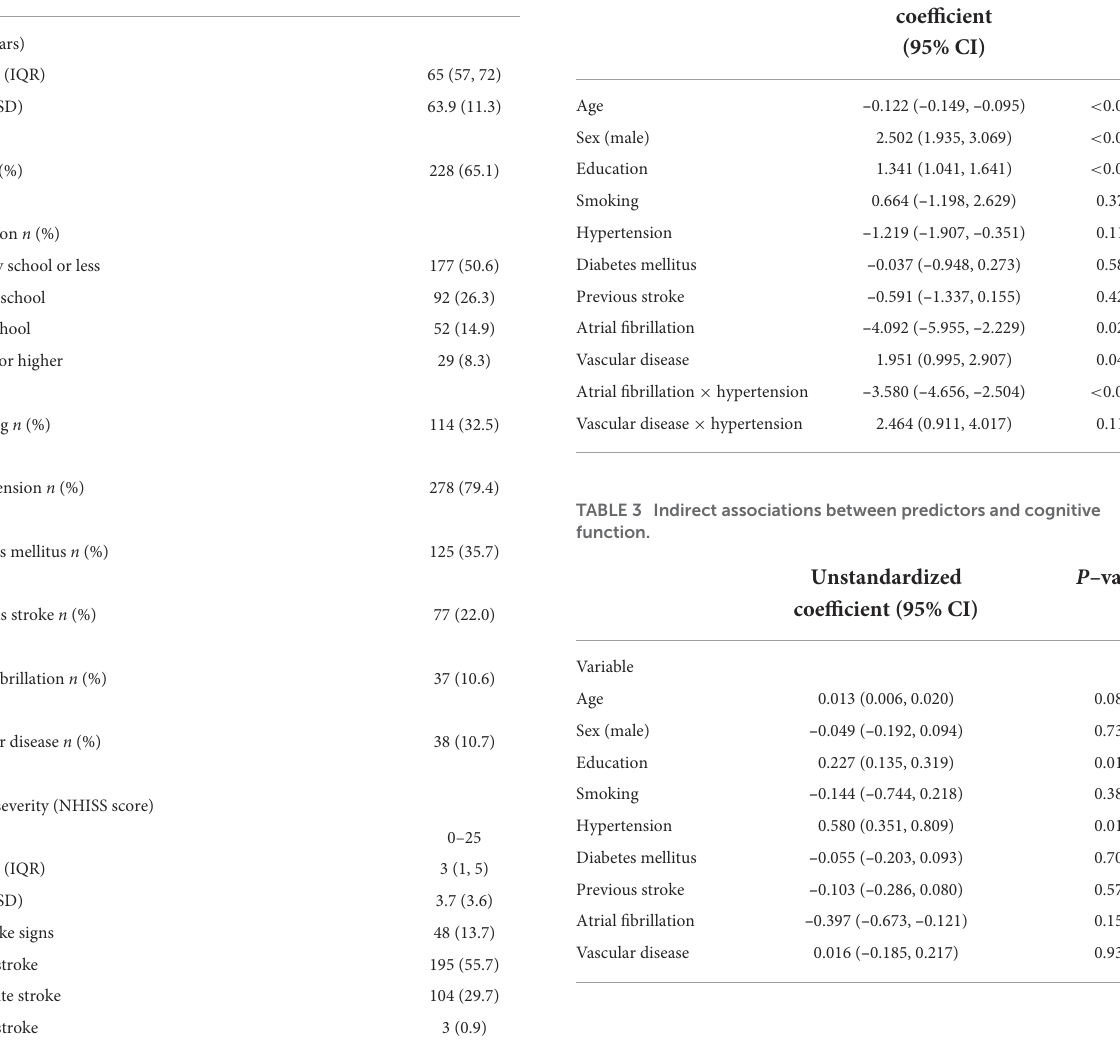
TABLE 1 Demographic, clinical, and cognitive data of all participants ( n = 350).